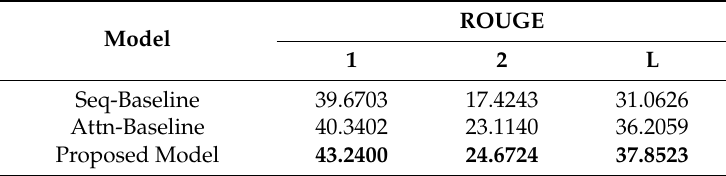
Figure 3. The change of ROUGE-1 scores according to (cid:101) on the validation set. Table 4. ROUGE score on the test